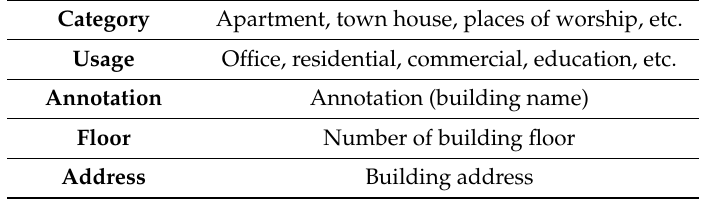
Table 1. Example of 1:1000 digital map building layer